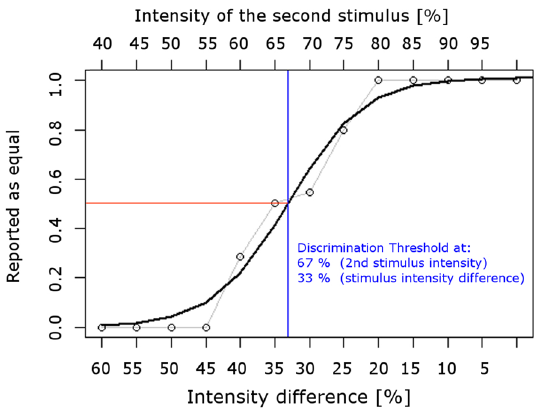
Figure 2. Intensity discrimination example, indicating the ratio of equal/unequal responses from one participant. Here, responses were ambiguous in the range between 40% and 25% intensity differences. We defined the intensity at which both answers would be given with the same probability (0.5) as the discrimination threshold. This point was estimated using a sigmoidal